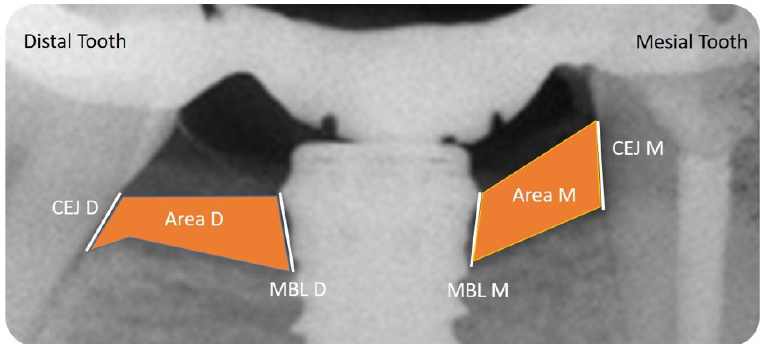
Figure 2. The following radiographic parameters were evaluated to measure MBL M (Mesial Marginal Bone level), MBL D (Distal Marginal Bone Level), CEJ M (Mesial Cement–Enamel Junction), CEJ D (Distal Cement–Enamel Junction), Area M (Mesial Bone level Area) and Area D (Distal Bone level